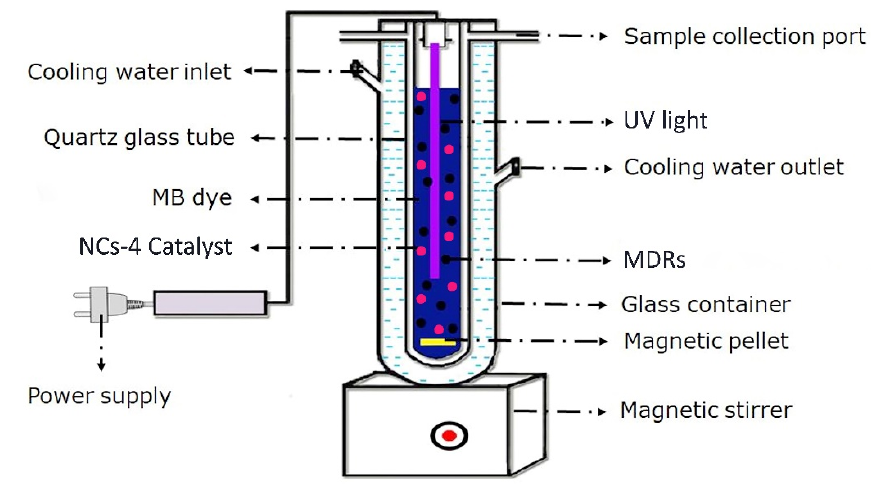
Figure 6. Photocatalytic inactivation test setup under UV light exposure.